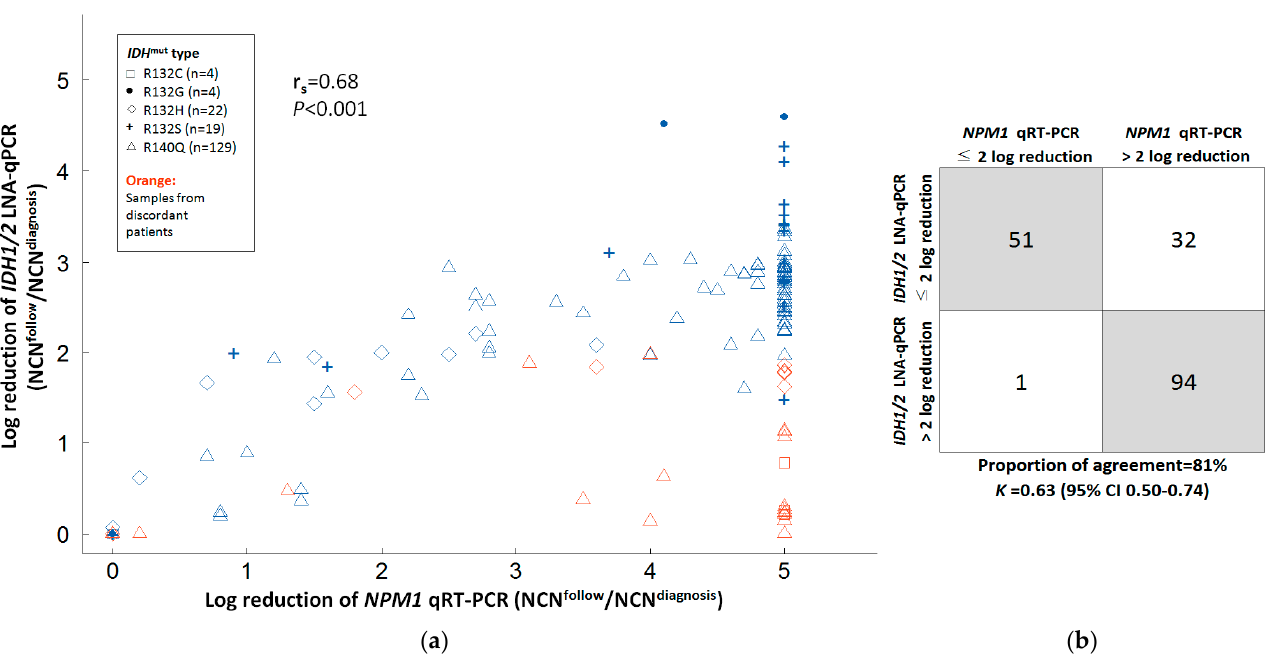
Figure 4. Correlation and agreement between IDH1/2 LNA ‐ qPCR MRD and NPM1 RT ‐ qPCR MRD in serial bone marrow samples. ( a ) Correlation between IDH1/2 LNA ‐ qPCR and NPM1 RT ‐ qPCR MRD by log reduction. Gray dashed lines showed two ‐ log reduction of IDH1/2 LNA ‐ qPCR and NPM1 RT ‐ qPCR MRD. Orange points represent samples from patients with discordant reduction of IDH1/2 LNA ‐ qPCR in complete remission status. ( b ) Agreement between IDH1/2 LNA ‐ qPCR and NPM1 RT ‐ qPCR MRD for all samples.